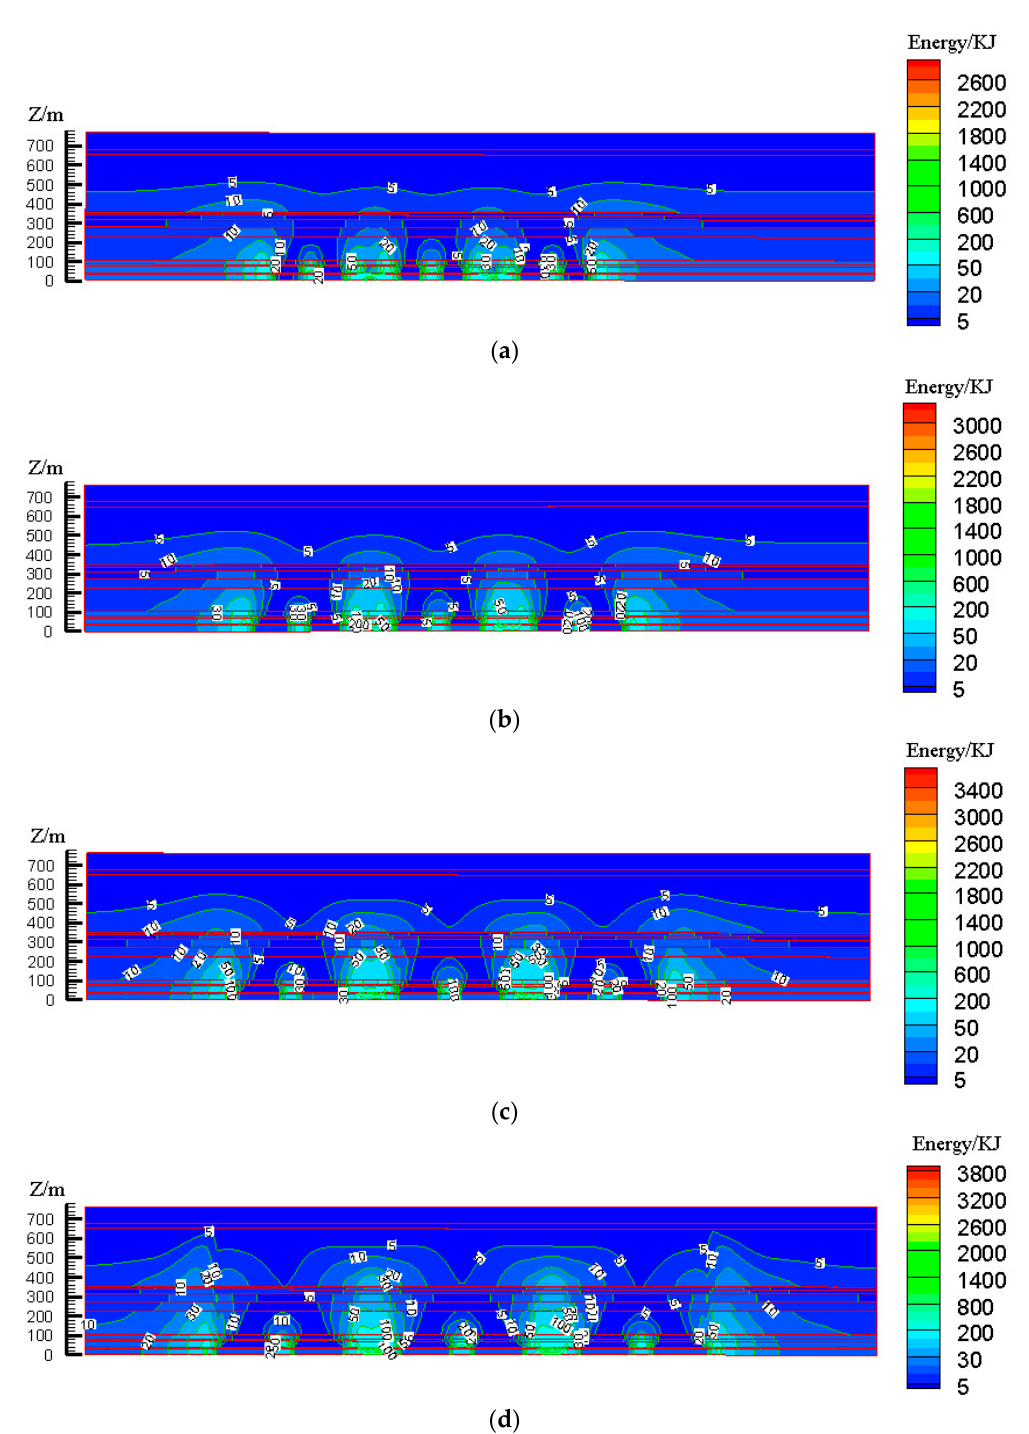
According to the design scheme in Table 6, the FLAC3D numerical simulation software was applied. The corresponding strata and surface subsidence data and energy polling Figure 13. Strata and surface subsidence rule of partial filling mining based on the main key stratum distribution values at different buried depths were extracted. The corresponding subsidence under different caving face scales; ( a ) width of caving face = 200 m. ( b ) Width of caving face = 250m. ( c ) Width of caving face = 300 m. ( d ) Width of caving face = 350 m. curves and energy distribution diagrams were plotted (Figures 16 and 17).